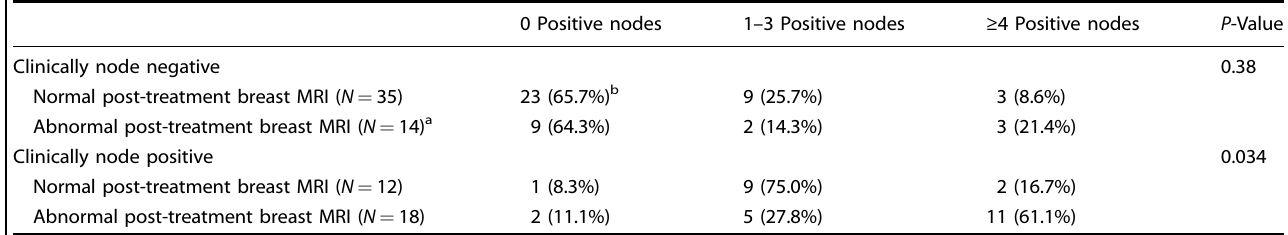
Table 4. Association between nodal disease burden on pathology and MRI fi ndings in clinically node negative and clinically node positive